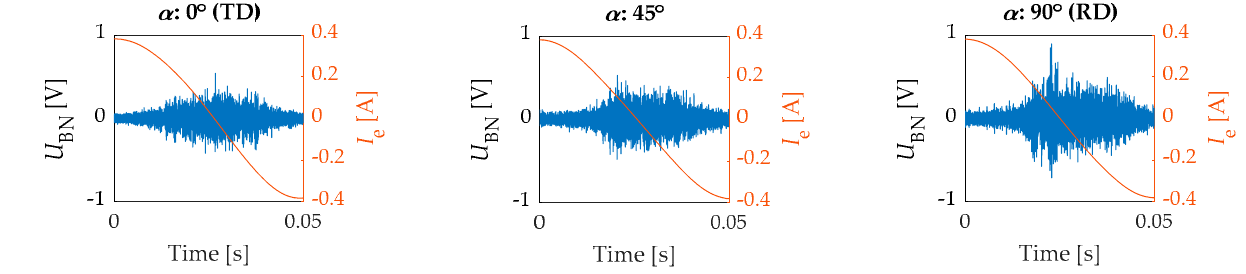
Figure 2. Exemplary U BN burst and magnetizing current course I e Figure 2 . Exemplary U BN burst and magnetizing current course I e .